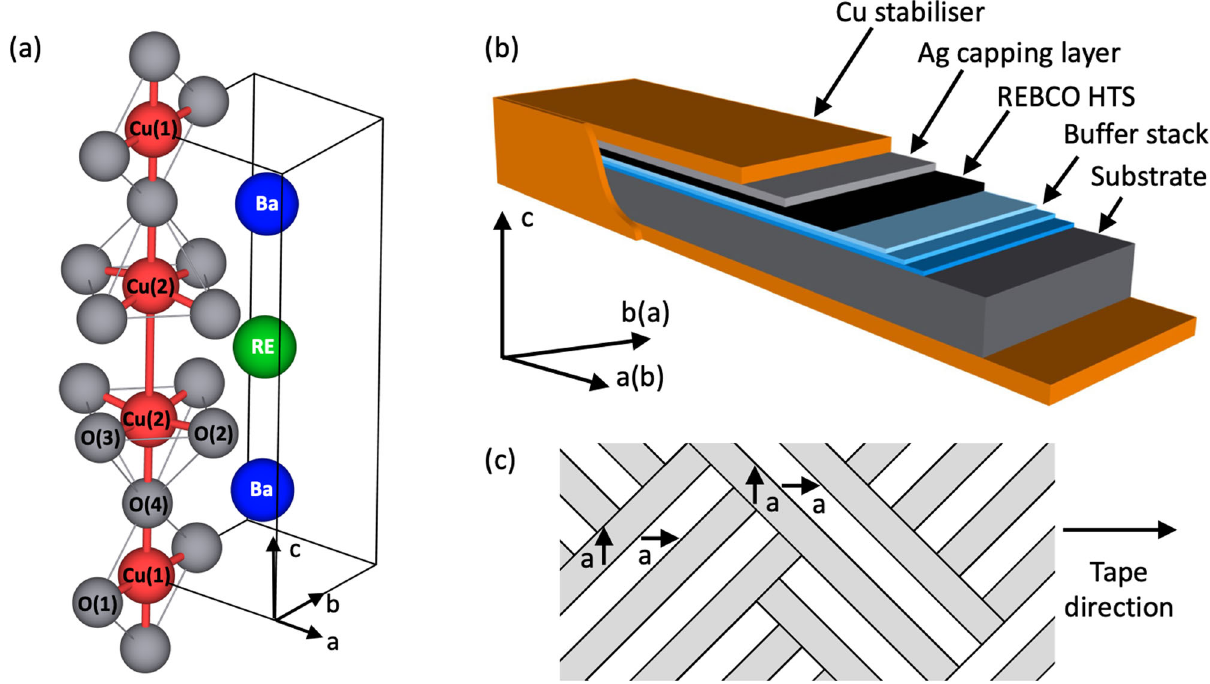
Fig. 1 Schematic diagrams of a REBa 2 Cu 3 O 7 − δ (RE = rare-earth element), REBCO, coated conductor. a Part of the REBCO unit cell showing the two different Cu sites (in red) and their coordination with O atoms (in grey). The Cu(1) chain atoms are 4-fold coordinated in the ( b , c ) plane by O(1) and O(4) atoms, whereas the Cu(2) plane atoms are 5-fold coordinated by the O(2) and O(3) atoms in the ( a , b ) plane plus the apical O(4) atom. b Schematic diagram of a generic coated conductor tape. c Schematic diagram of the twin structure with arrows representing the direction of the a